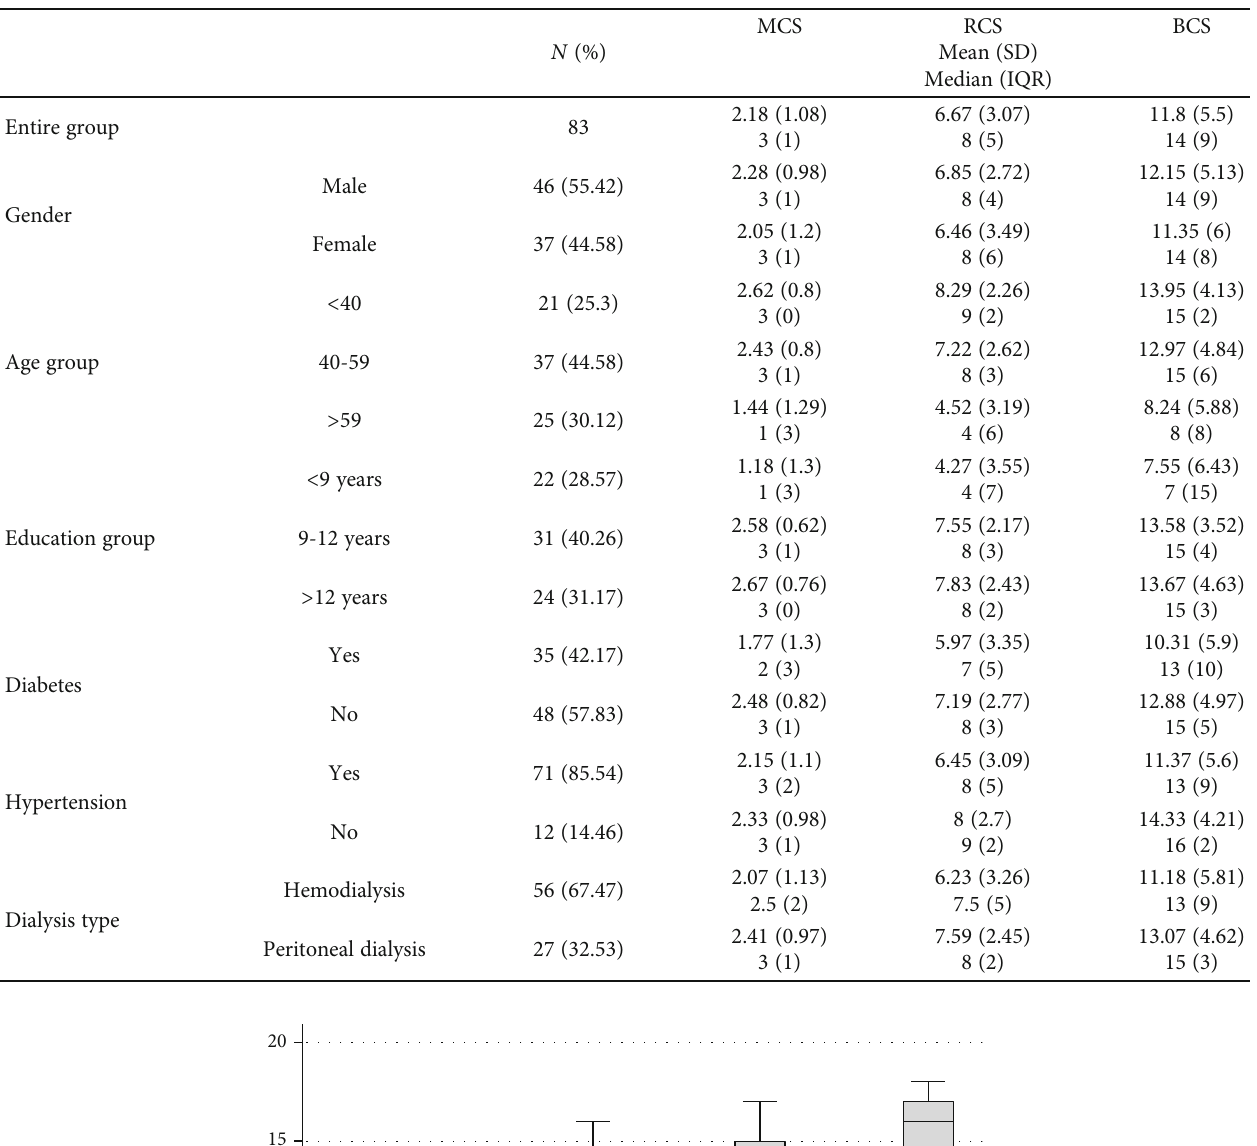
Table 1: Baseline patient data and their performance on each of the scales. SD: standard deviation; IQR: interquartile range.